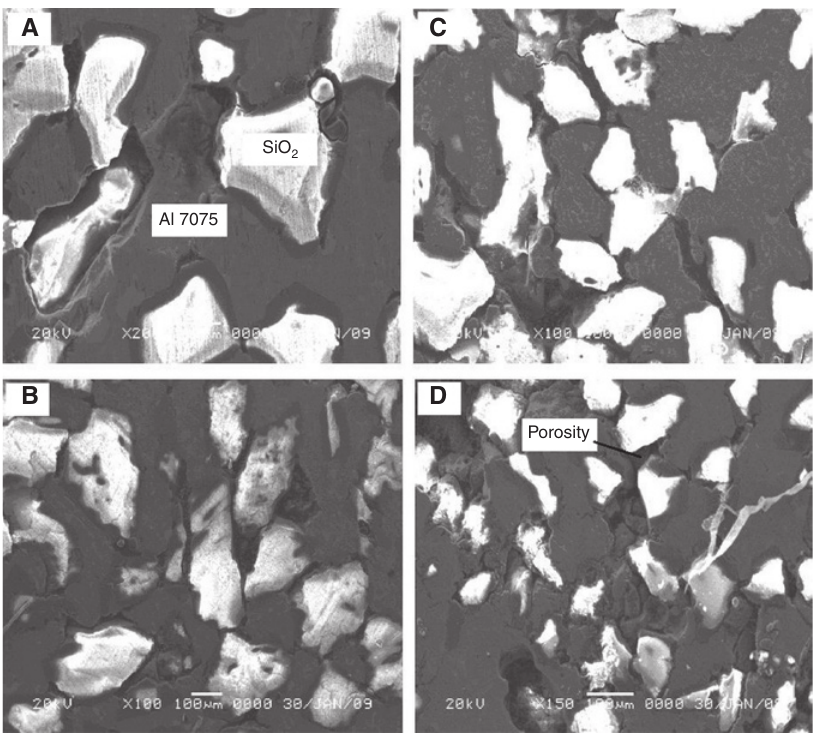
Figure 4: SEM micrographs of composites with reinforcement sizes of (A) 420 μ m, (B) 210 μ m, (C) 149 μ m, and (D) 105 μ